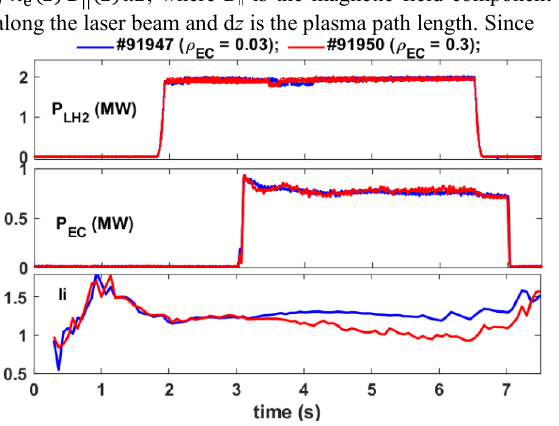
Fig. 6. Waveform of current density profiles modified by adjusting the EC deposition in LHCD sustained plasmas.